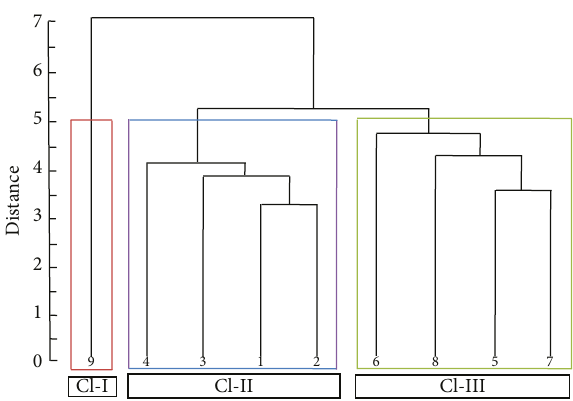
Figure 1: Dendrogram based on mean performance of variables among 9 exotic sugarcane genotypes according to average clustering and Euclidean distance method, where 1 is GT11, 2 is GT15, 3 is GT17, 4 is VMC86-550, 5 is HoCP85-845, 6 is HoCP96-540, 7 is HoCP95- 988, 8 is HoCP91-555, and 9 is